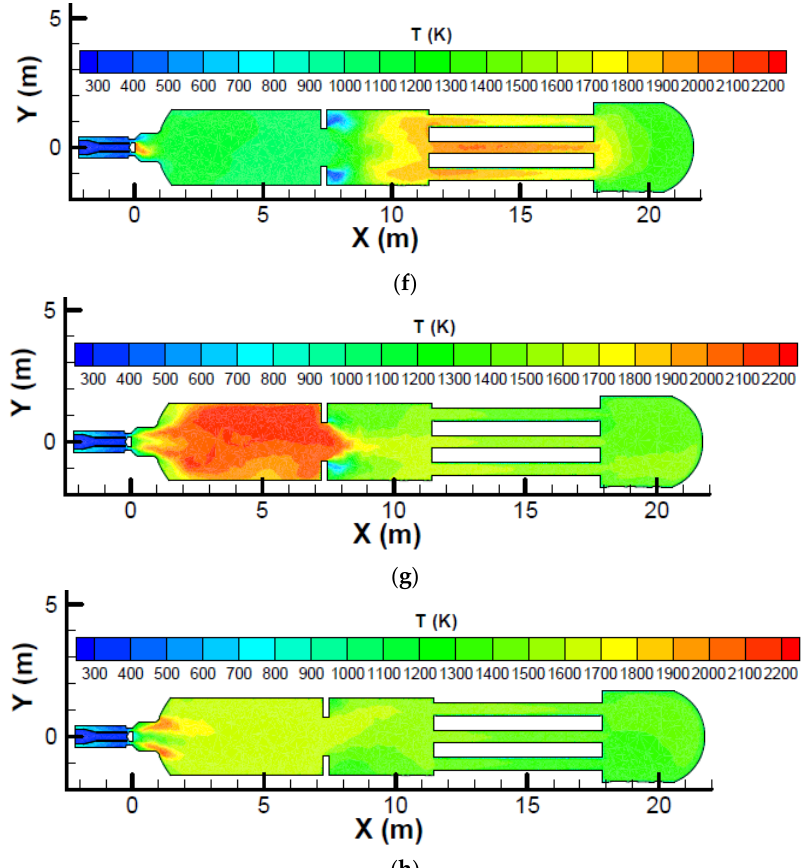
Figure 6. The temperature profile on the symmetric plane for a SRU thermal reactor with different zone 1 fuel mass fractions: ( a ) Zone 1 fuel mass fraction of 0.0625; ( b ) Zone 1 fuel mass fraction of 0.125; ( c ) Zone 1 fuel mass fraction of 0.375; ( d ) Zone 1 fuel mass fraction of 0.875; ( e ) Zone 1 fuel mass fraction of 0.0625; ( f ) Zone 1 fuel mass fraction of 0.125; ( g ) Zone 1 fuel mass fraction of 0.375; ( h ) Zone 1 fuel mass fraction of 0.895 (note:( a – d ) are for oxygen ‐ normal operations and ( e – h ) are for oxygen ‐ rich operations).